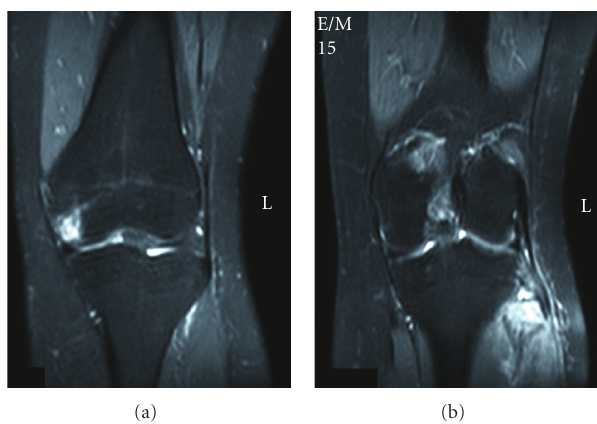
Figure 4: MRI of the left knee showing medial condyle bruise (a) as well as edema of the head of fibula due to fracture (b).